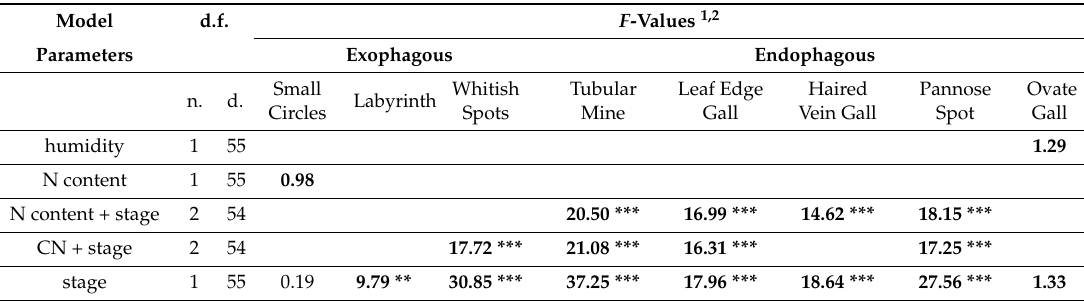
1 F -values in boldface: best models based on the BIC ( ∆ BIC = 0–2); 2 Results of analyses of variance: * = p < 0.05; ** = p < 0.01; *** = p < 0.001; n. = numerator; d. = denominator; humidity = relative air humidity; N content = leaf nitrogen content; stage = plant ontogenetic stage; CN = C/N